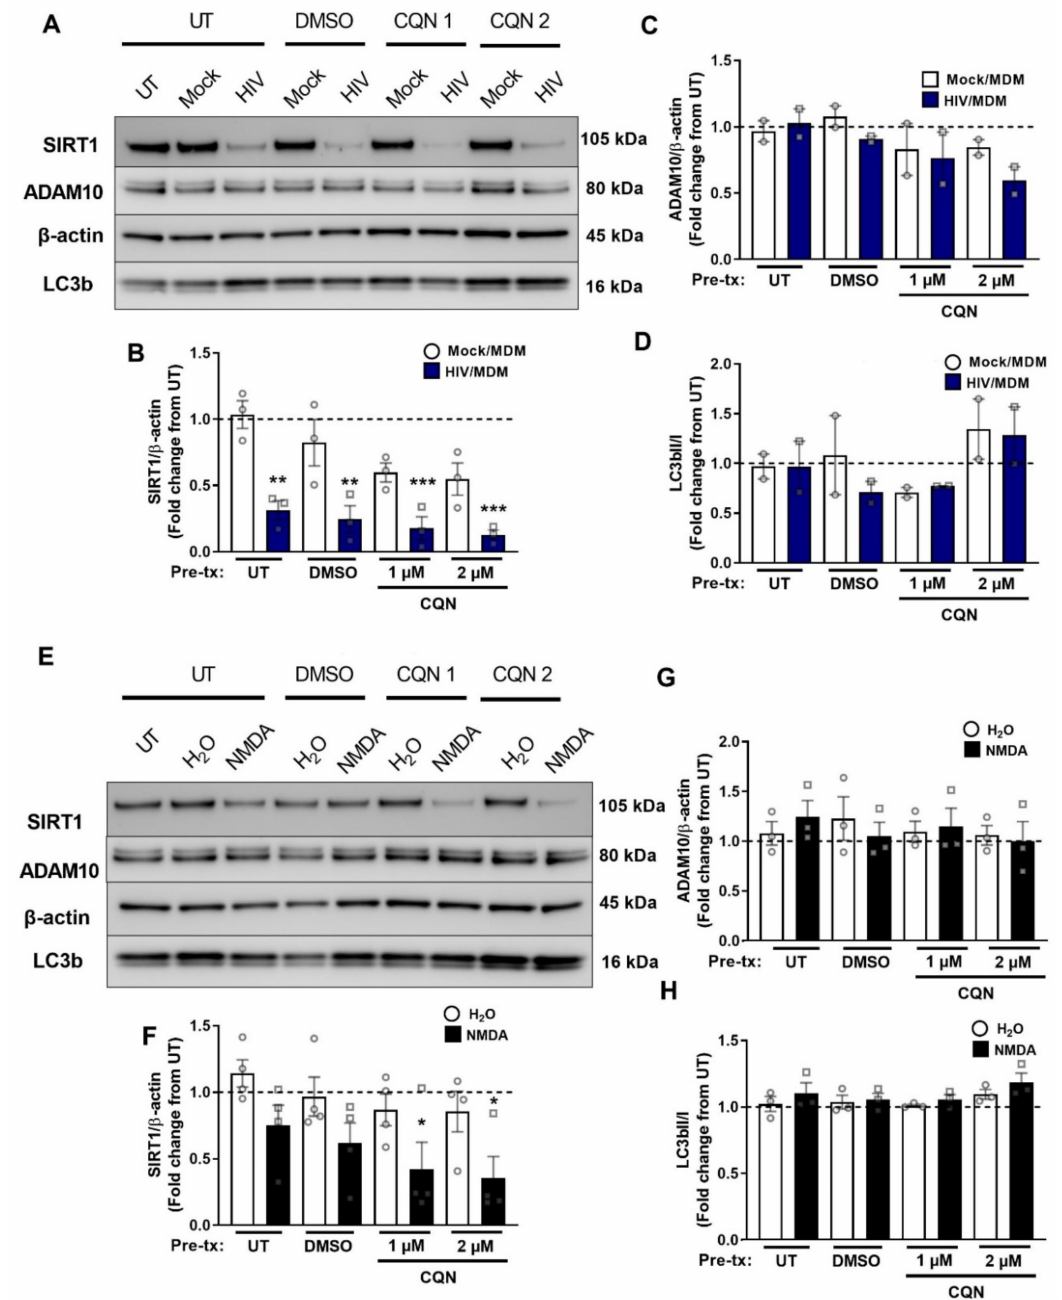
Figure 7. Early SIRT1 decrease by HIV/MDMs does not seem to be mediated by autophagy. Protein lysates were collected from rat neuronal cultures after a 4 h pretreatment with vehicle (DMSO) or chloroquine and a 2 h treatment with HIV/MDMs. Representative blots are shown ( A ). Chloroquine did not rescue levels of SIRT1 decrease by HIV/MDMs ( B ). Statistical significance was calculated using two-way ANOVA followed by Tukey’s post hoc. * Represents p < 0.05, ** p < 0.01, *** p < 0.001 compared to Mock/MDMs ( n = 3). ADAM10 levels were unchanged ( C ) while the LC3BII/I ratio seems to tend toward an increase ( D ). Protein lysates were collected from rat neuronal cultures after a 4 h pretreatment with DMSO or CQN and a 2 h treatment with vehicle for NMDA (H 2 O) or NMDA. Representative blots are shown ( E ). Chloroquine did not seem to restore levels of SIRT1 and decreased SIRT1 ( F ). Statistical significance was calculated using two-way ANOVA followed by Tukey’s post hoc. * Represents p < 0.05 compared to H 2 O ( n = 4). ADAM10 levels seem to be unchanged ( G ) while the LC3BII/I ratio seems to tend toward an increase ( H ). Dotted line represents untreated